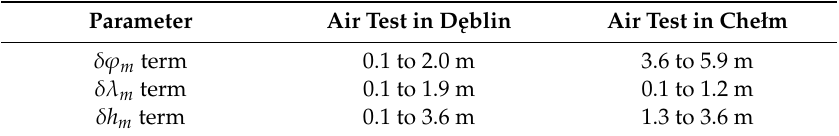
Table 5. Comparison of the standard deviation of an average aircraft position in the flight tests in D˛eblin and Chełm.